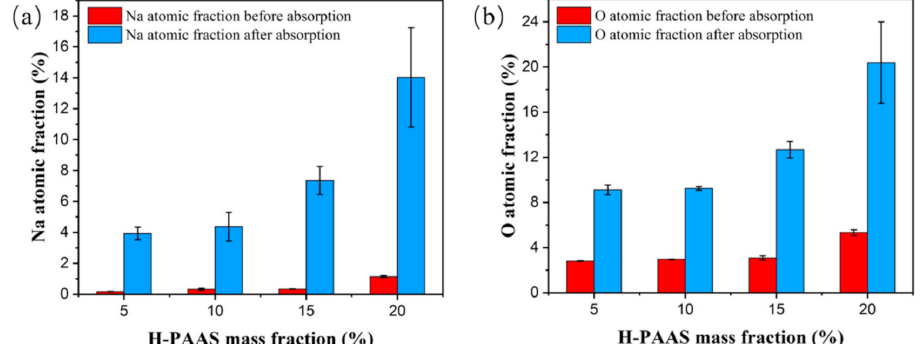
Figure 13. Na ( a ) and O ( b ) atomic fractions before and after water absorption.